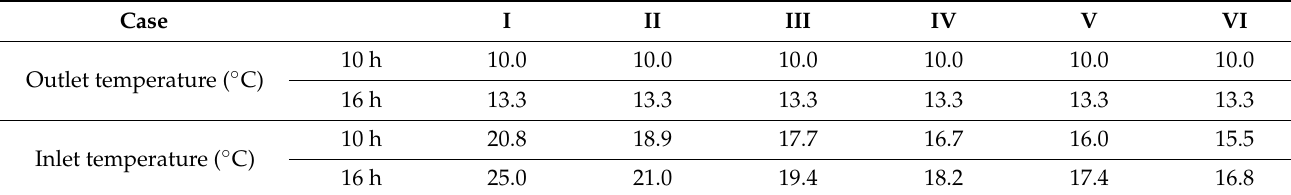
Table 3. Input data of the inlet and outlet temperatures at 10 h and at 16 h.